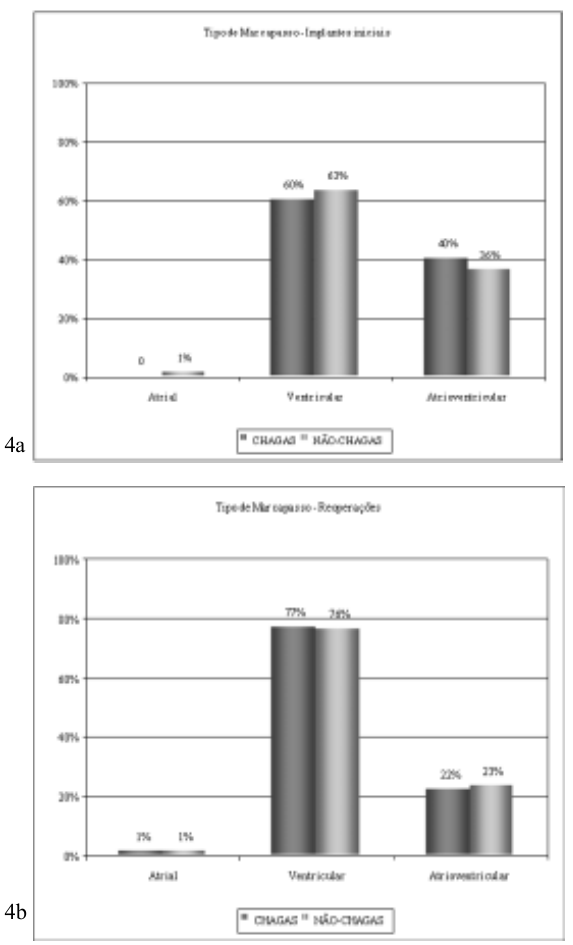
Fig. 4 - Tipo de marcapasso utilizado nos implantes iniciais (4a) e nas reoperações